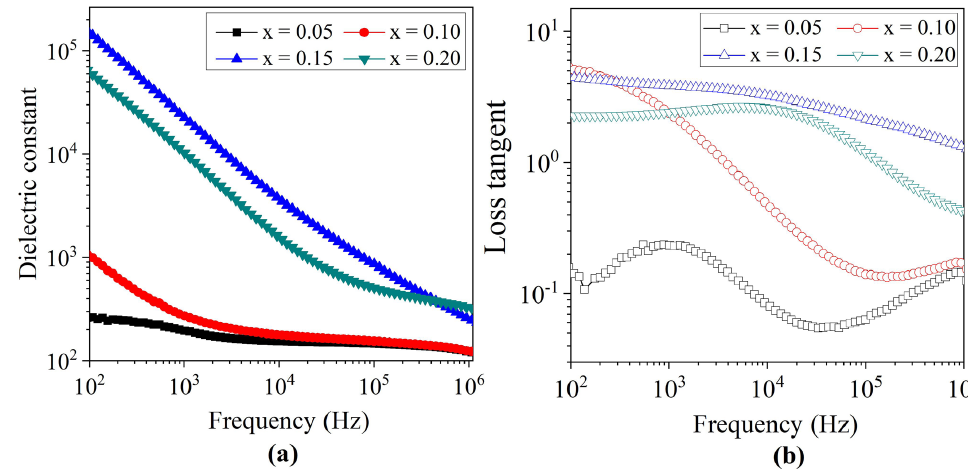
Figure 6. Frequency dependence of (a) dielectric constant and (b) loss tangent of the samples with various K